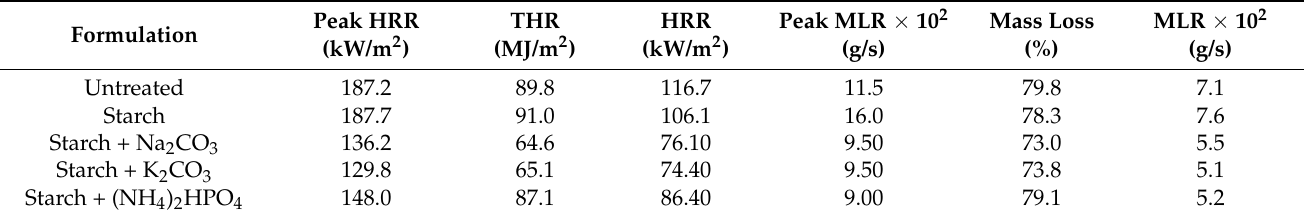
Table 1. The averages of THR, HRR, and MLR and the corresponding peak values measured in the standard cone calorimeter at 35 kW/m 2